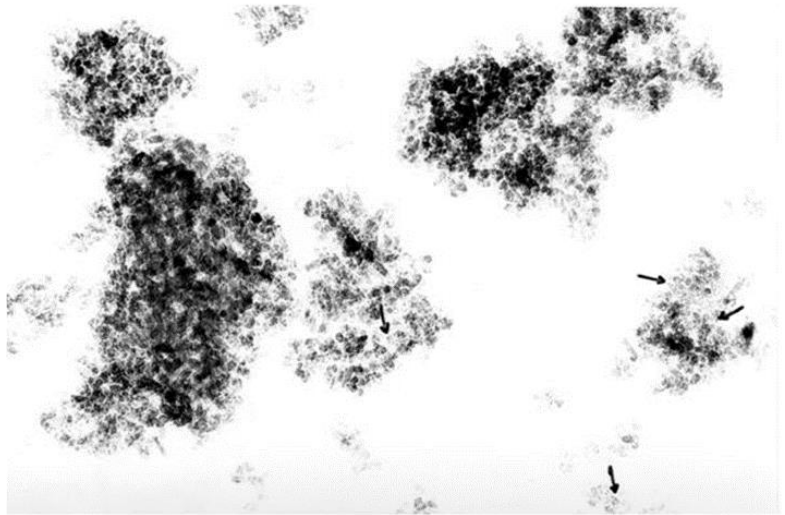
Figure A1. Microphotography of Ru/Al 2 O 3 catalyst.